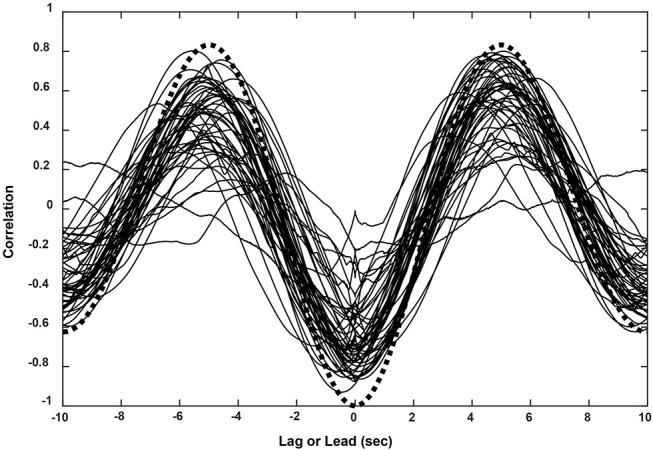
Cross-correlation functions for eye movement and pupil responses (sinusoidal pursuit task) from all 52 subjects. The functions corresponded closely to the theoretical result for two cosines at the stimulus frequency of 0.1 Hz (black dashed line).